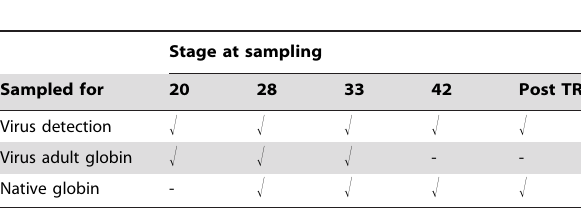
Table 1. Sampling schedule for tadpoles infected with recombinant